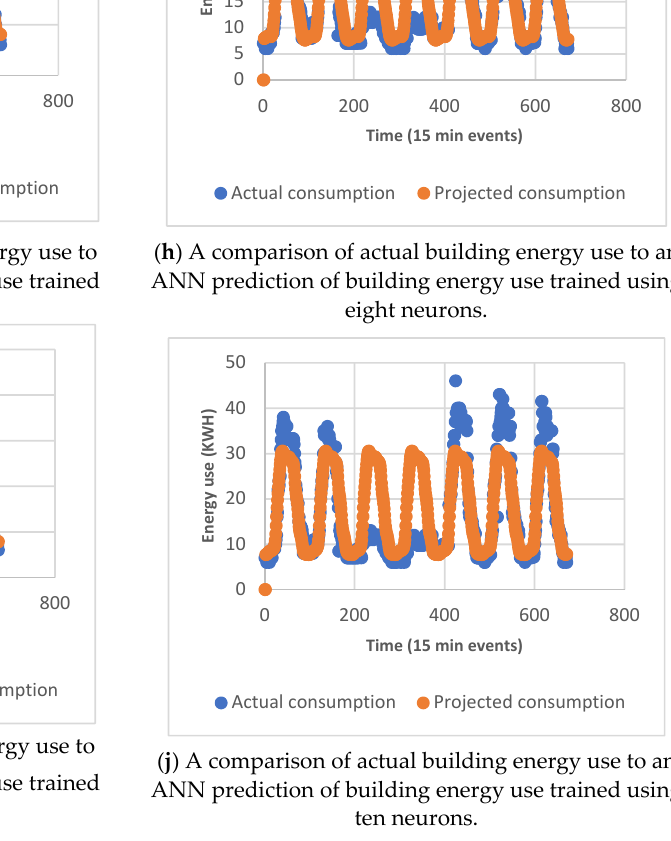
Figure 5. Comparison of ANN predictions using different numbers of neurons. Because ANNs are considered to be “black box” models, it is unknown why at two neurons, the predictions became flat, i.e., constant. However, it should be noted that the predicted value was the average of all of the energy uses, i.e., 17.81 kWh. A selection of three neurons resulted in the best prediction accuracy, and increasing the number of neu- rons further only resulted in the same prediction accuracy and a longer convergence time. Additionally, information such as the root mean square error (RMSE) and standard error (SE) of the impact of varying the number of neurons can be found in Table A1.